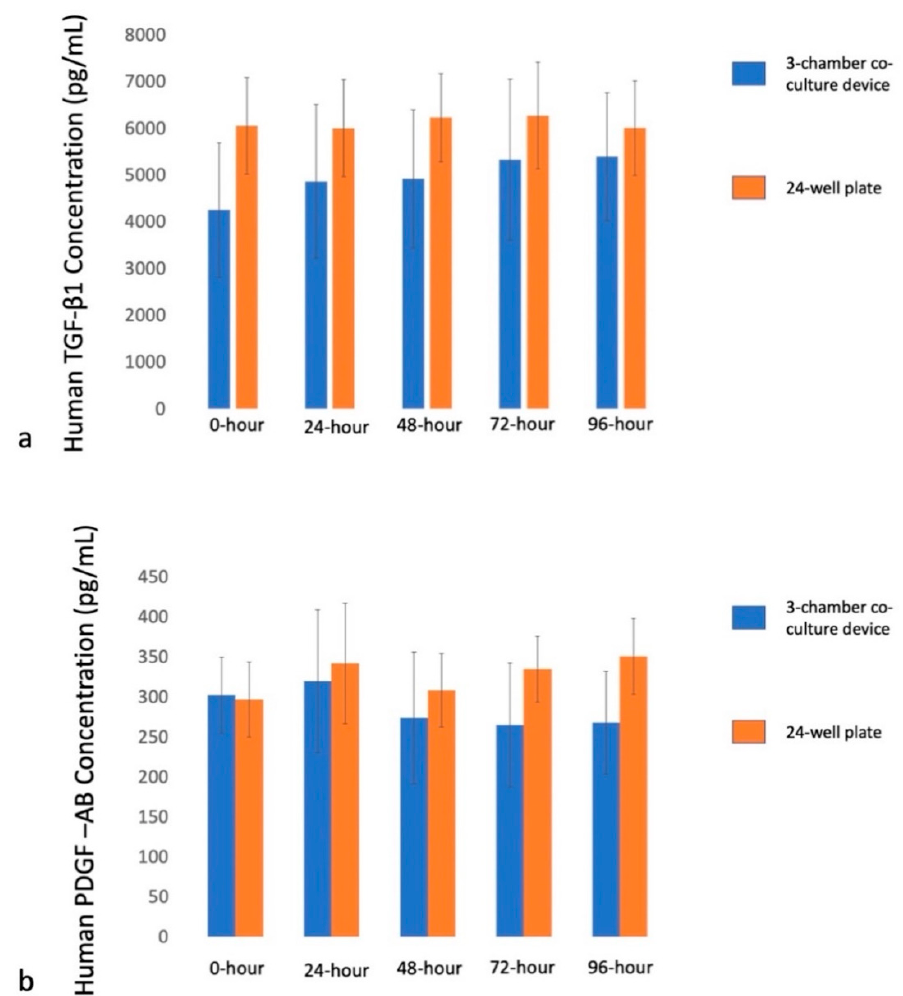
Figure 2. Cytokines release at different time points in 3-chamber co-culture device and conventional 24-well plate. ( a ) TGF- β 1 release at 0 h, 24 h, 48 h, 72 h and 96 h. ( b ) PDGF-AB release at 0 h, 24 h, 48 h, 72 h, and 96 h.